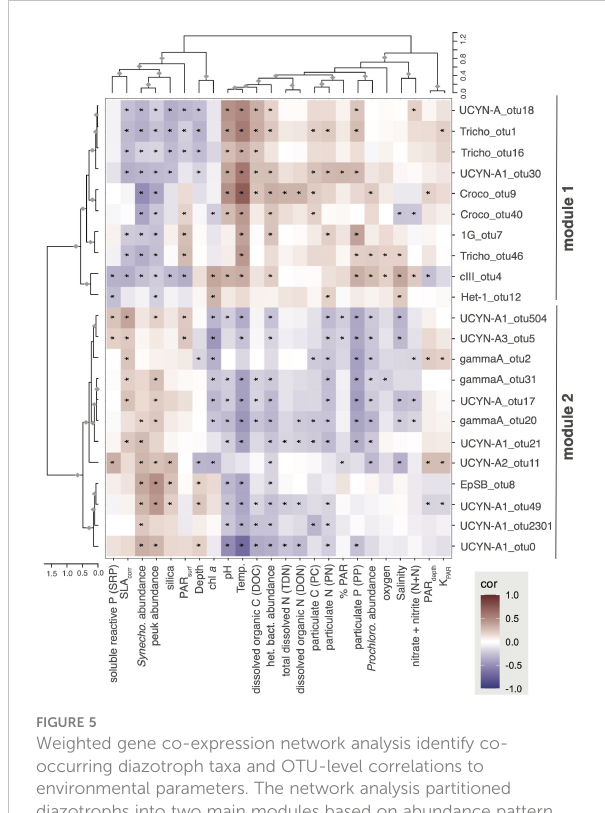
FIGURE 5 Weighted gene co-expression network analysis identify co- occurring diazotroph taxa and OTU-level correlations to environmental parameters. The network analysis partitioned diazotrophs into two main modules based on abundance pattern similarity over the time series (with abundances summed from 5- 75 m on each date). Dominant Trichodesimum and Crocosphaera OTUs were in module 1 (M1) while most UCYN-A OTUs were in module 2 (M2). Generally, diazotrophs in M1 and M2 had opposite correlations to environmental variables. ♦ Row or column cluster is signi fi cant (bootstrapping, alpha ≥ 0.95); *Pearson correlation is signi fi cant (p <